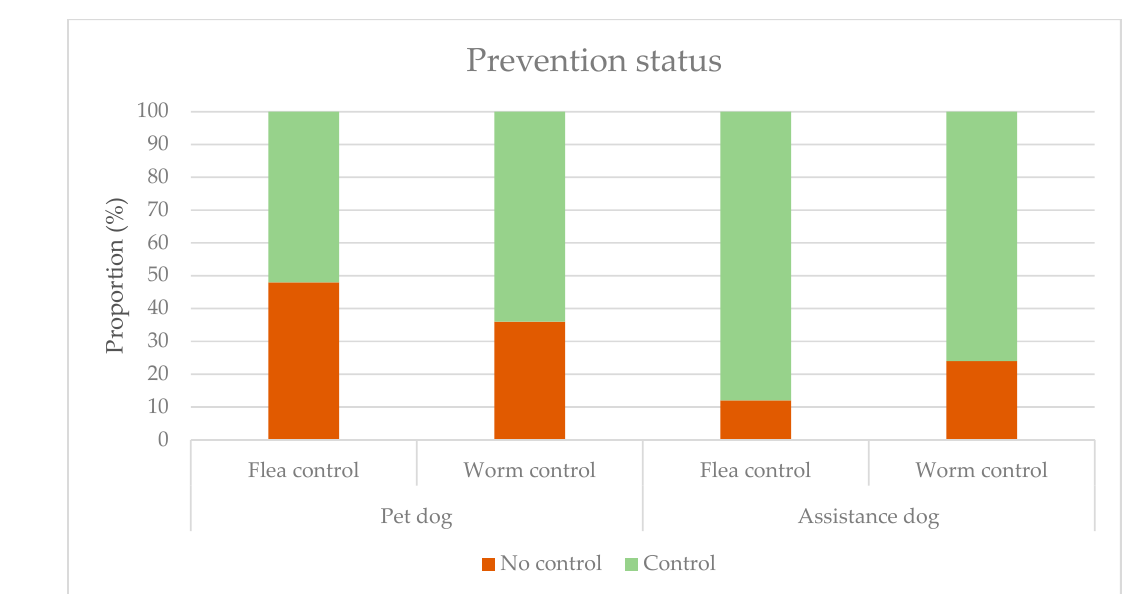
Figure 2. The prevention status of pet dogs (PDs) and assistance dogs (ADs). As neutering is mandatory for ADs, the proportion of neutered dogs in this group was high, being 84%. The reason why this number is not 100% is that there were three young dogs which were yet to be neutered and one dog which was made an exception. This was a Silken Windsprite, a breed known for having a high risk of complications during or after anaesthesia. In the PD group, 56% were neutered. This was significantly different from the AD group ( p < 0.05).